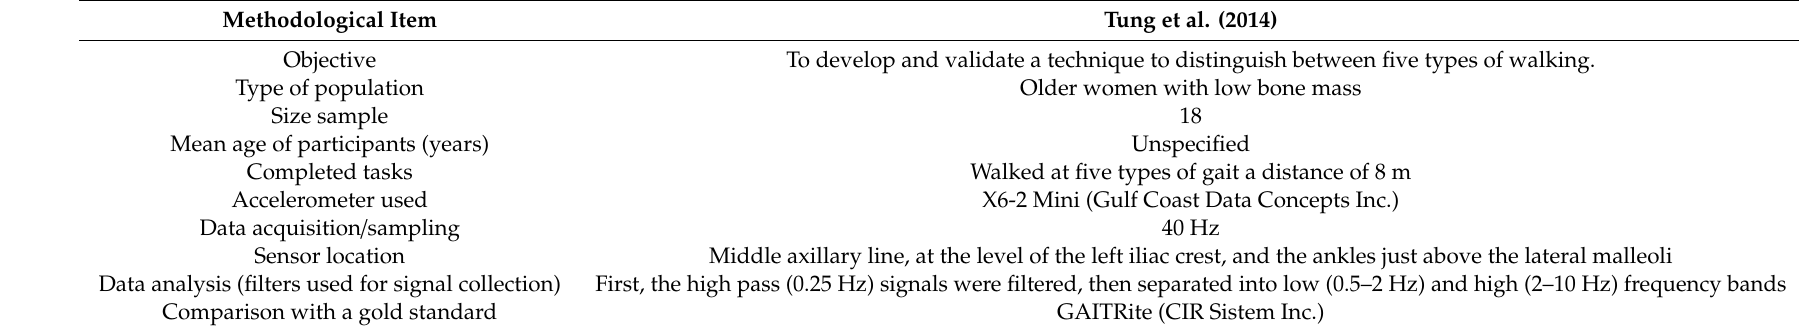
Table A8. Methodological details of the research